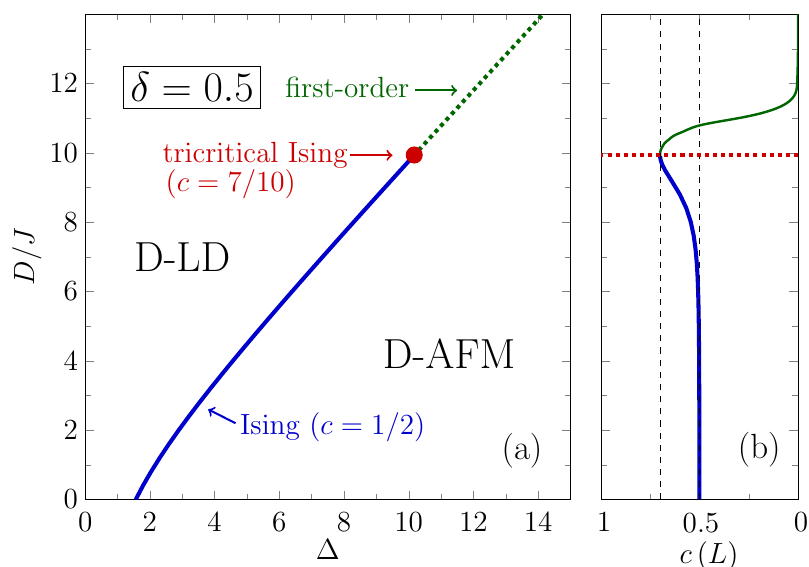
Figure 7: (a) Phase diagram of the model (2) for δ = 0.5. D-LD (cid:139) D-AFM phase boundary of the continuous Ising transition terminates at a tricritical Ising